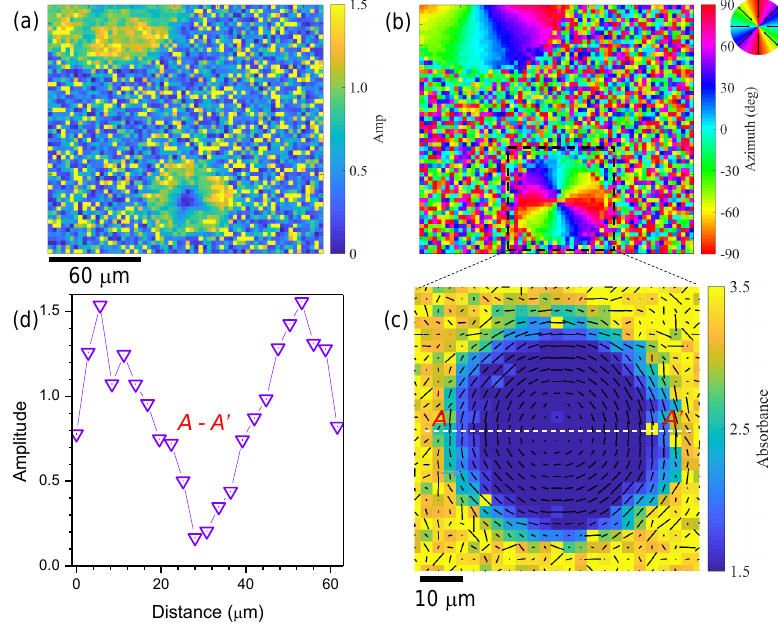
Figure 2. Circular grid reference measured with FPA; thermal-IR source. Orientation amplitude Amp ( a ), orientation azimuth ( b ), absorbance map overlaid with an orientation map ( c ), and central cross section A − A (cid:48) ( d ) all at 3000 cm − 1